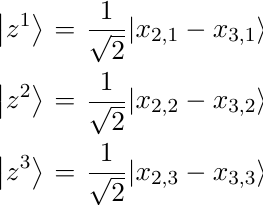
Figure 5 . The Z 2 grading of the Hilbert space spanned by the partial symmetries of S 3 H f are the \bosonic" and \fermionic" parts of this grading. The grading operator 1 (cid:0) 2 F , [see eq. (2.12)], gives +1 on H b and -1 on H f